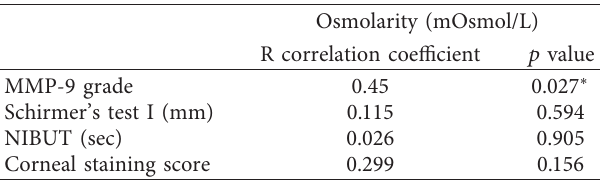
Figure 1: Correlation between osmolarity and ocular surface parameters. (a) MMP-9 grade, (b) Schirmer’s test I, (c) NIBUT, and (d) corneal staining scores. MMP-9 � matrix metalloproteinase-9, NIBUT � noninvasive tear break up time, and R � correlation coefficient. ∗ Indicates statistical significance ( p < 0 . 05). Table 4: Comparison of MMP-9 grade and osmolarity between Table 5: Correlation between osmolarity and ocular surface ocular surface parameter groups according to dry eye severity.